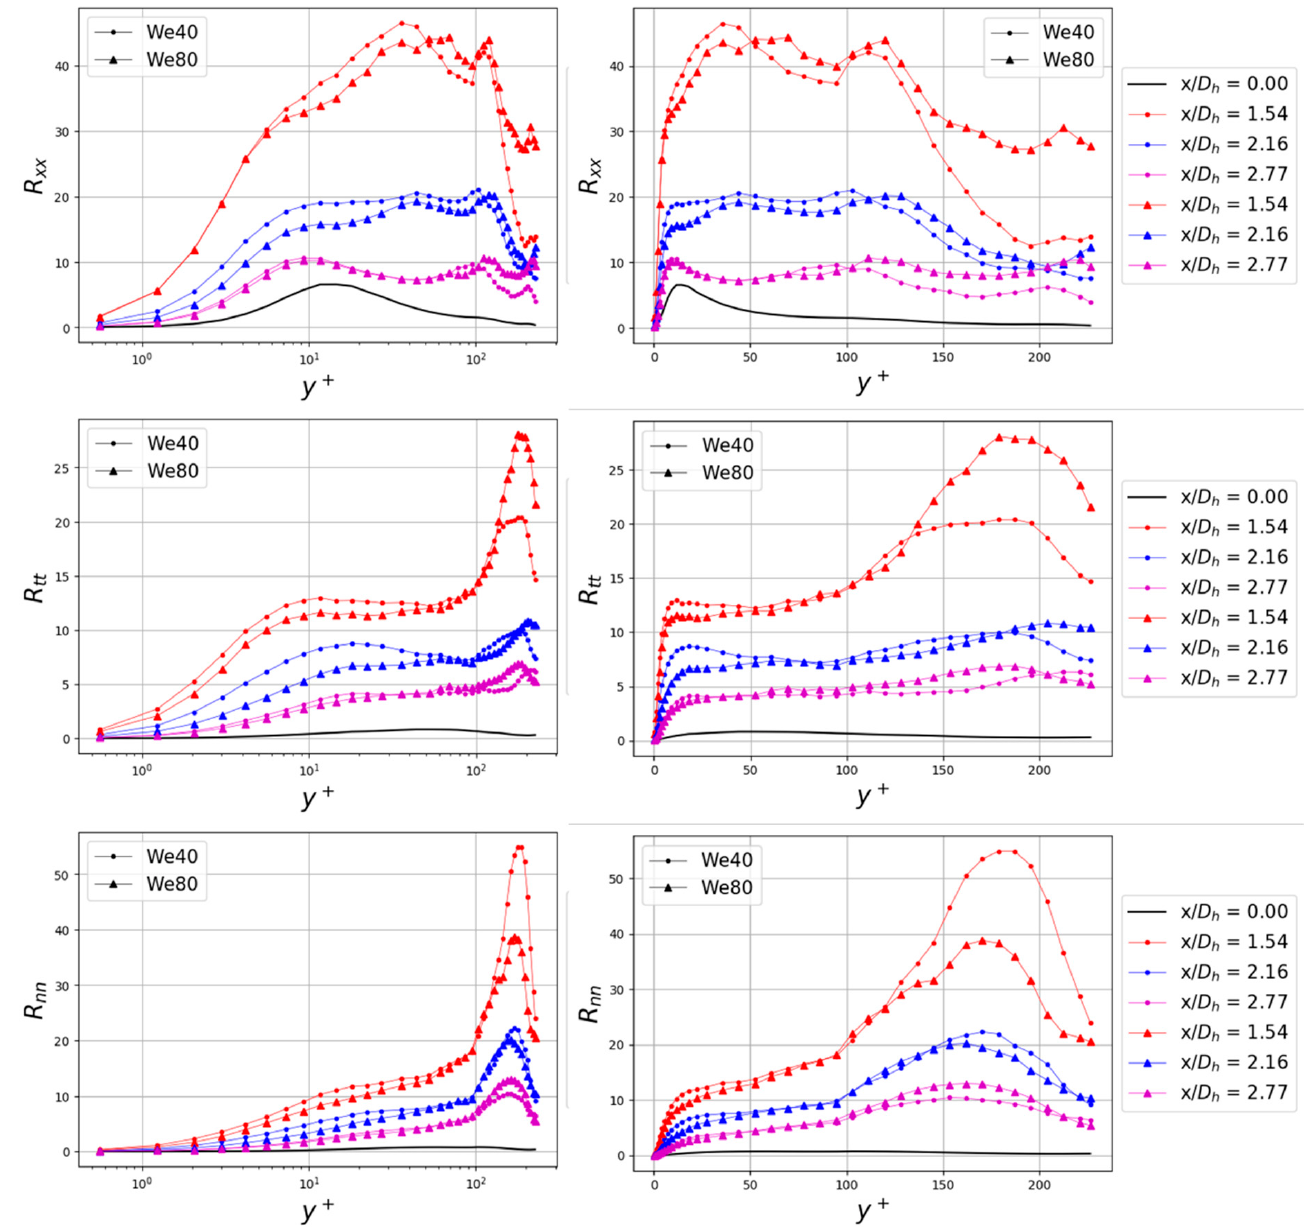
Figure 9. Comparison of normalized principal Reynolds stress component profile for the We40 and We80 cases. Profiles at three downstream probe planes are shown (lateral coordinates are rotated to 𝑡 − 𝑛 ).